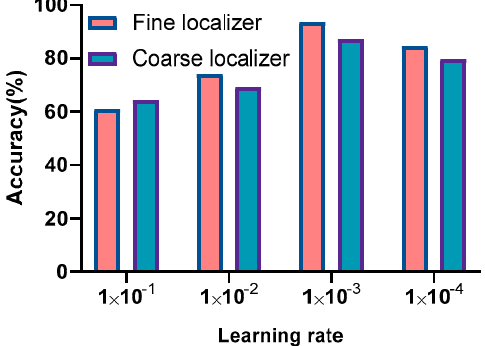
Figure 12. Positioning performance of Resnet-based coarse localizer and transfer-learning-based fine localizer with different initial Lr values.